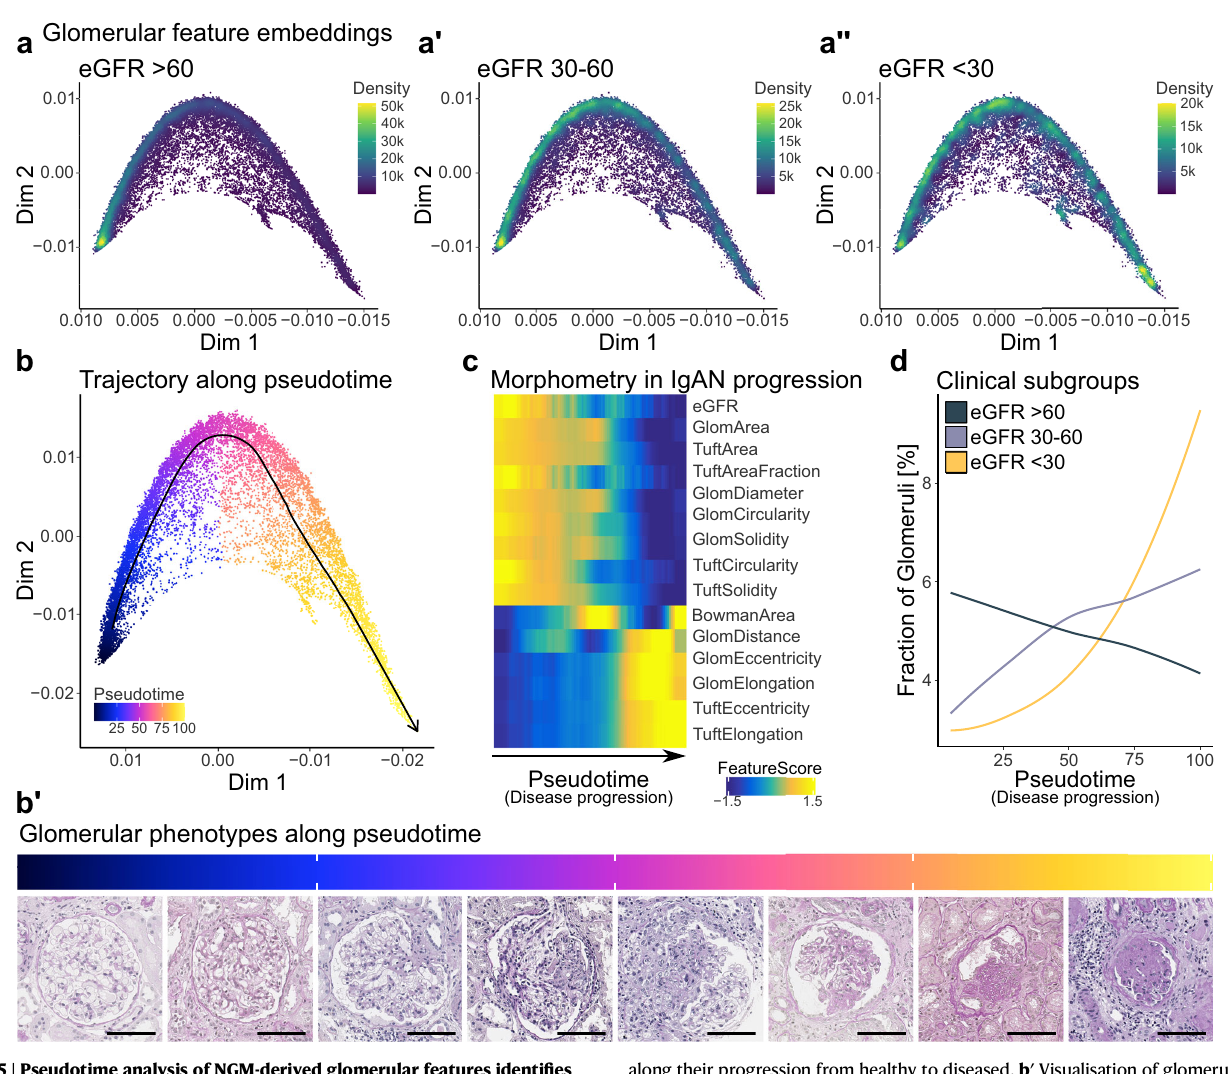
along their progression from healthy to diseased. b ′ Visualisation of glomerular phenotypes along the pseudotime. c Scaled feature expression heatmap including eGFRalongthepseudotimetrajectory. d Morphometricprogressionof glomerular instancesinclinicalsubgroupsbasedontheoverallreportedeGFR.Scalebarsizeis 100 µ m.SourcedataareprovidedasaSourceData fi le.eGFRestimated glomerular fi ltration rate, Dim diffusion map, IgAN IgA